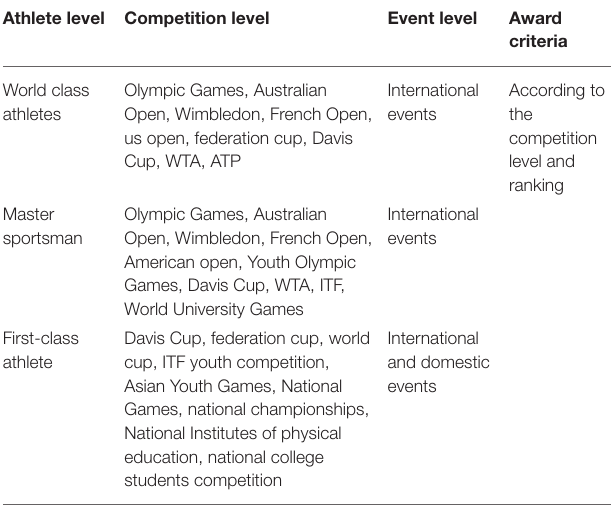
TABLE 8 | Awarding standard of technical level for Chinese tennis